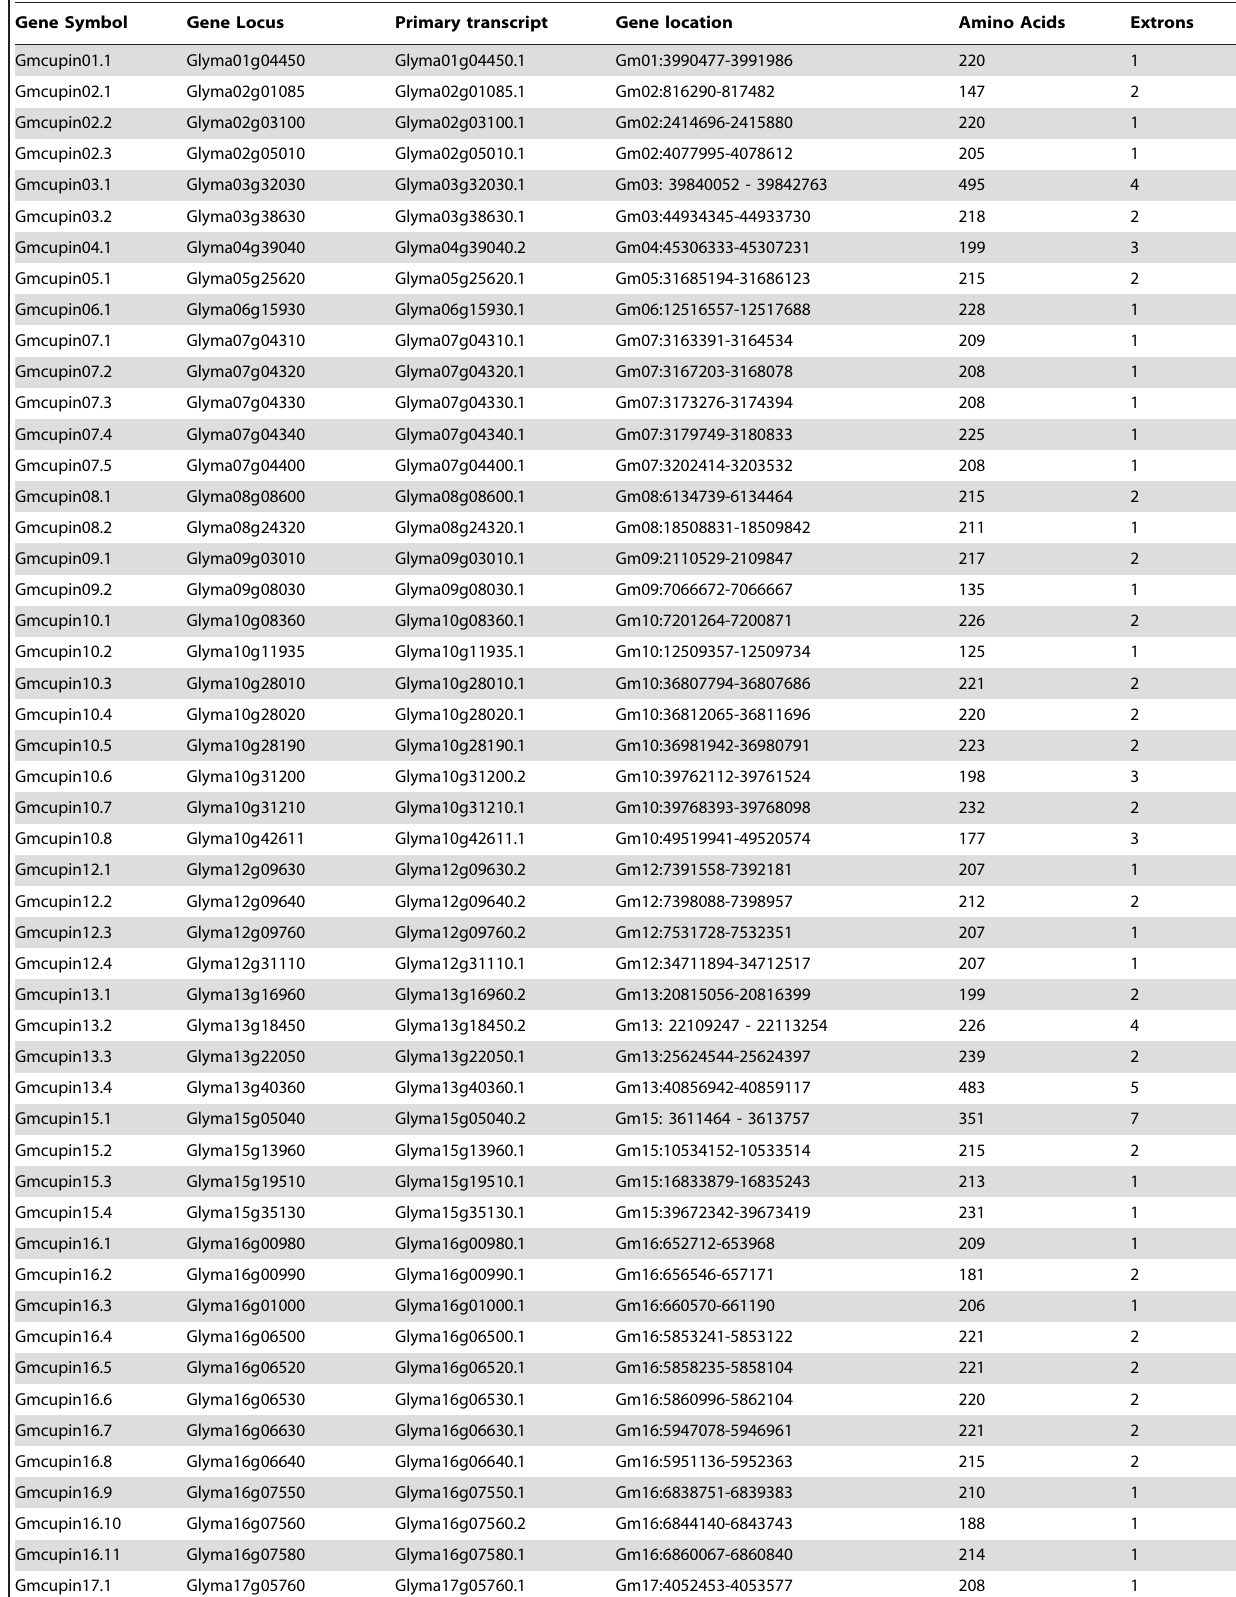
Table 1. Summary of Cupin family members in